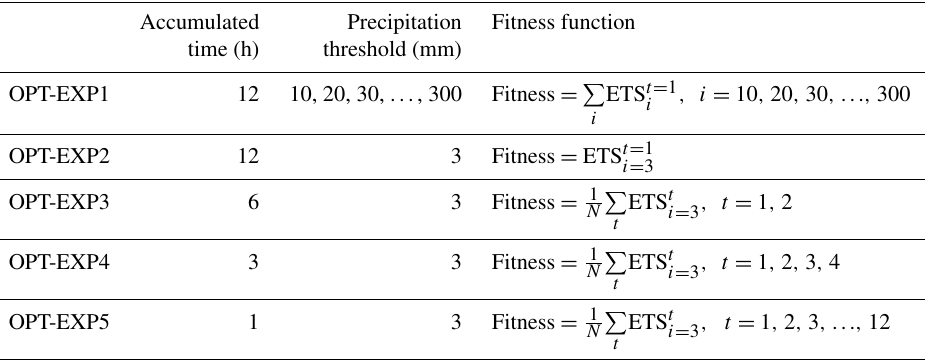
Table 3. The summary of the experiments. In the fitness function, i and t represent the precipitation threshold and the number of accumulated time instants, respectively. N is the total number of accumulated time